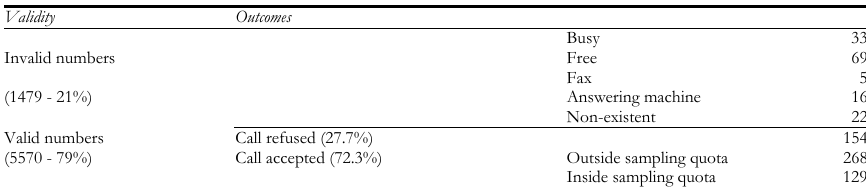
Phone calls and